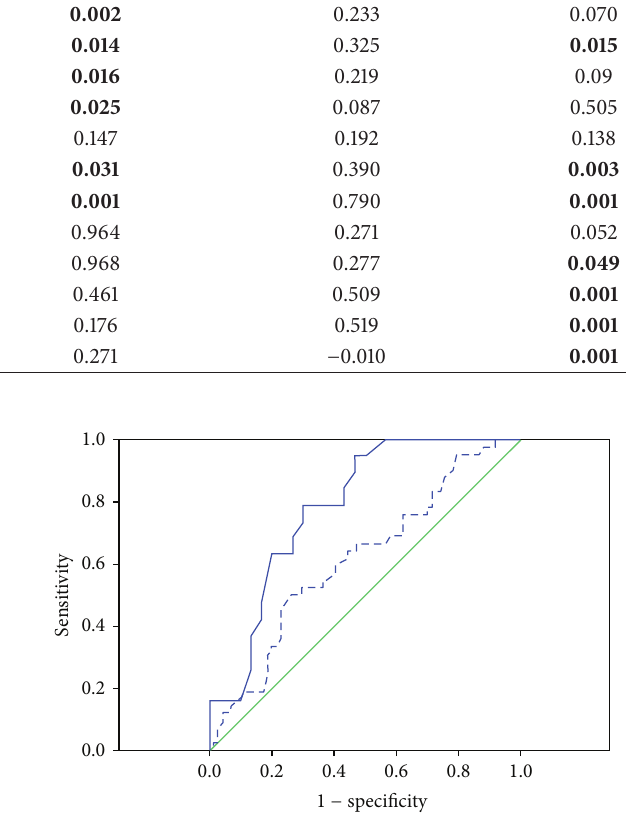
Figure 1: Receiver-operating characteristic (ROC) curve for the identification of NAFLD based on the visceral fat (cm) of adoles- cents. The area under the ROC curve of the boys was 0.784 (95% confidence interval 0.658–0.910). The WC cut-off point for the boys was4.20 cm.AndtheareaundertheROCcurveofthegirlswas0.615 (95% confidence interval 0.509–0.721). The WC cut-off point for the girls was